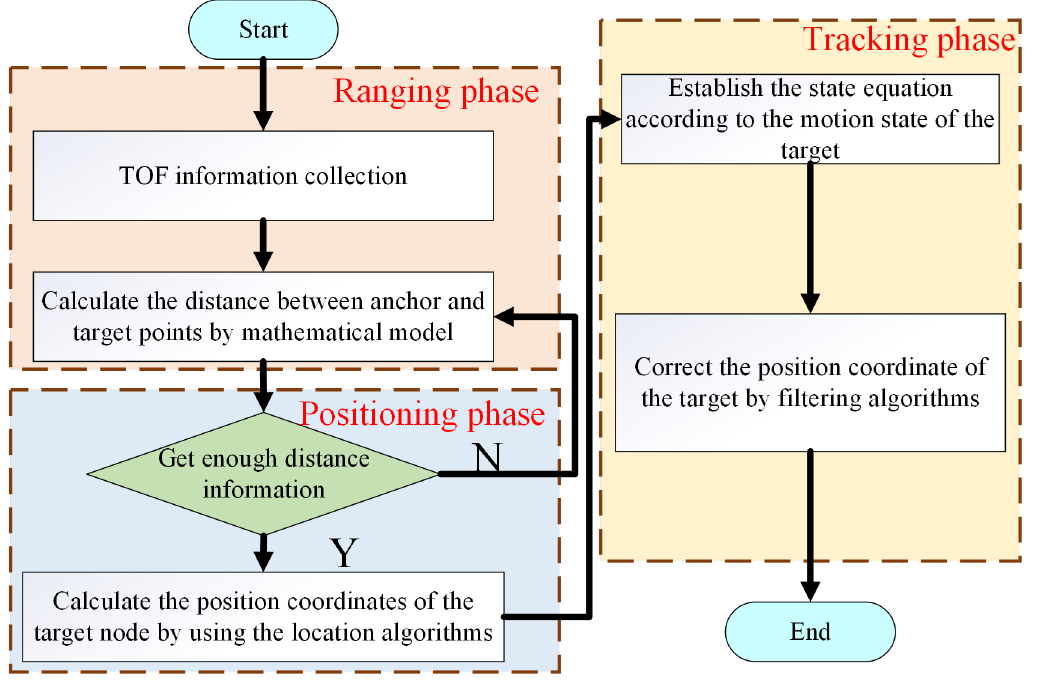
Figure 1. Overall model of accurate UWB